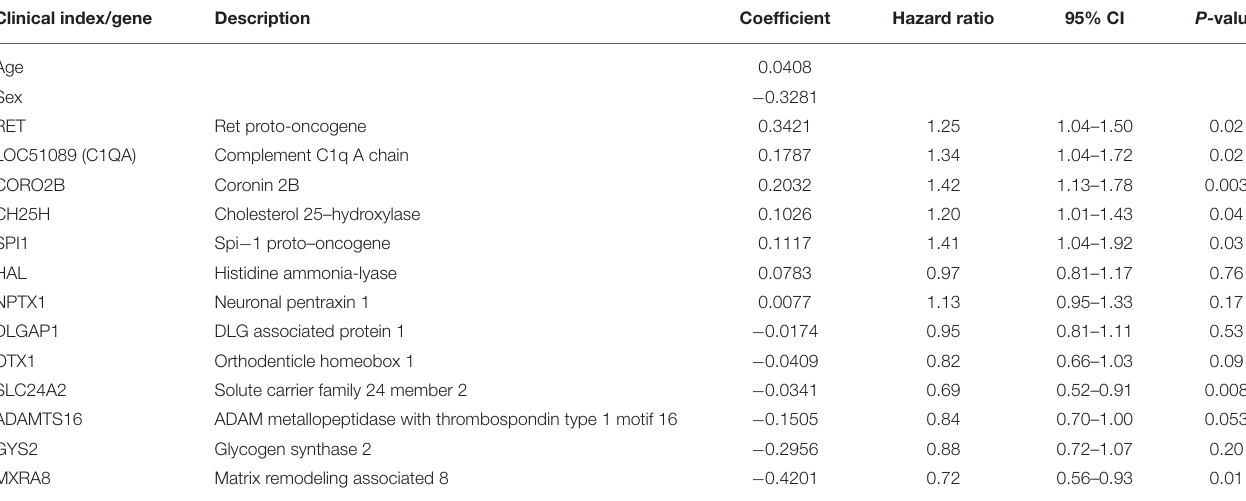
TABLE 2 | Thirteen key prognostic genes and two clinical indexes selected by the LASSO